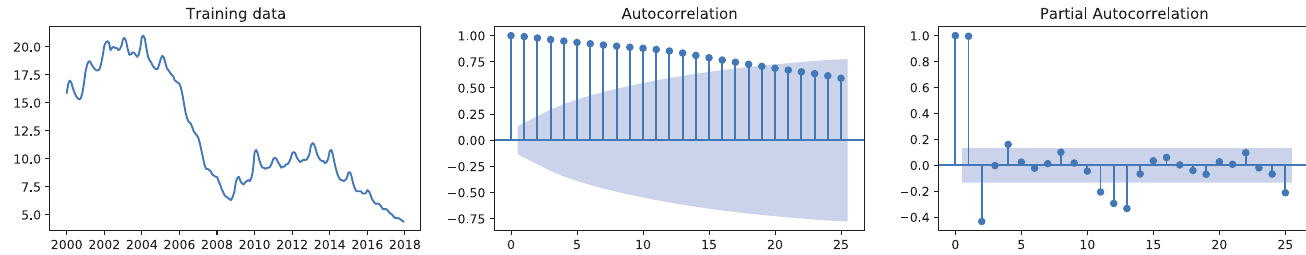
Figure 4. Training data, ACF and PACF plots for Hungary.